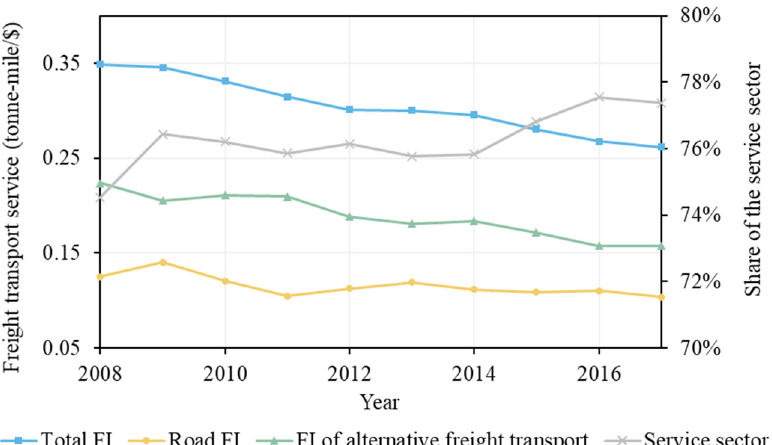
Figure 8. Freight intensity of the freight transport sector and share of service in the U.S. (FI: freight transport